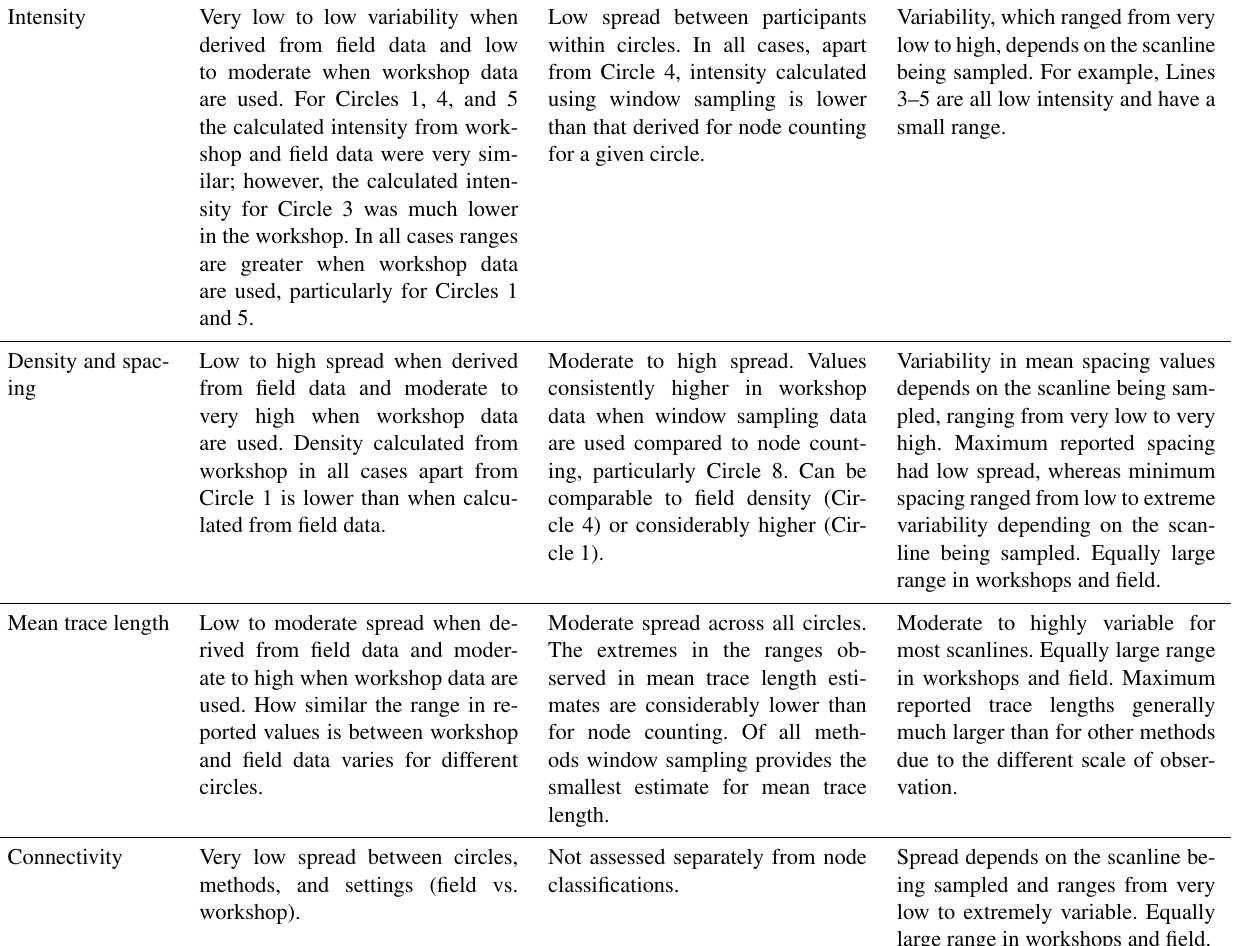
Table 7. Summary of the broad trends in fracture statistics derived from the three methods we explored; presented in Fig.